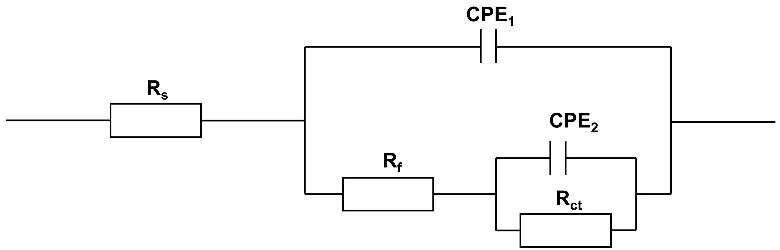
Figure 3. Nyquist plot of B ( a ) and A0 ( b ) with an increasing number of drying–wetting cycles.